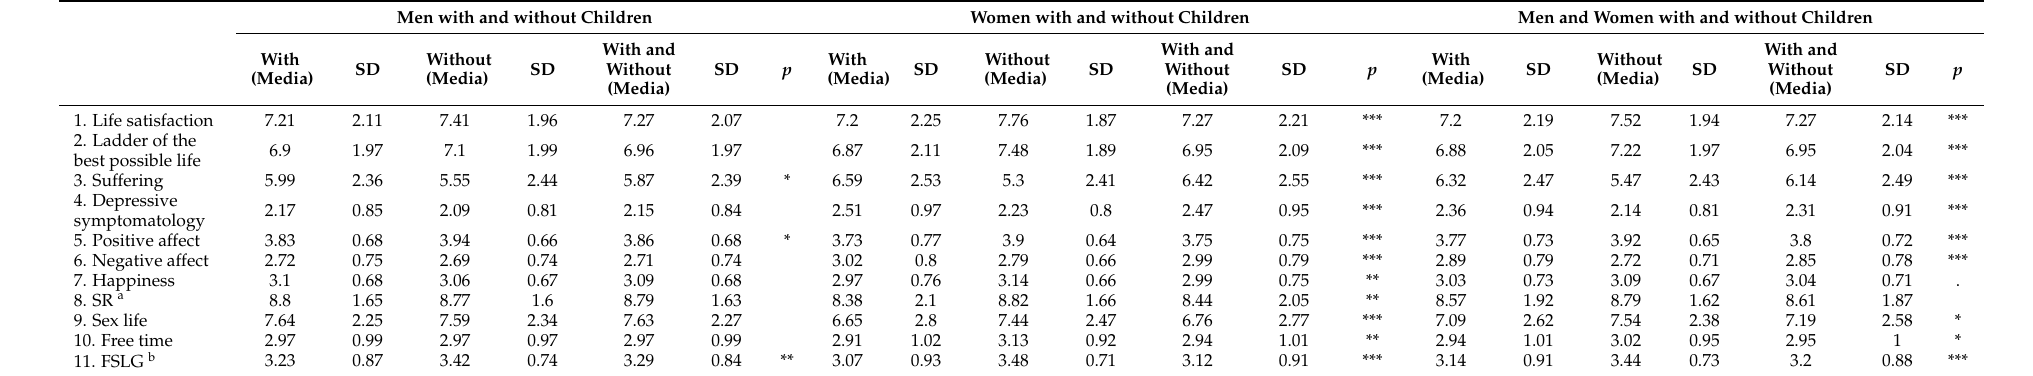
Table 1. Differences by sex between participants with and without children.